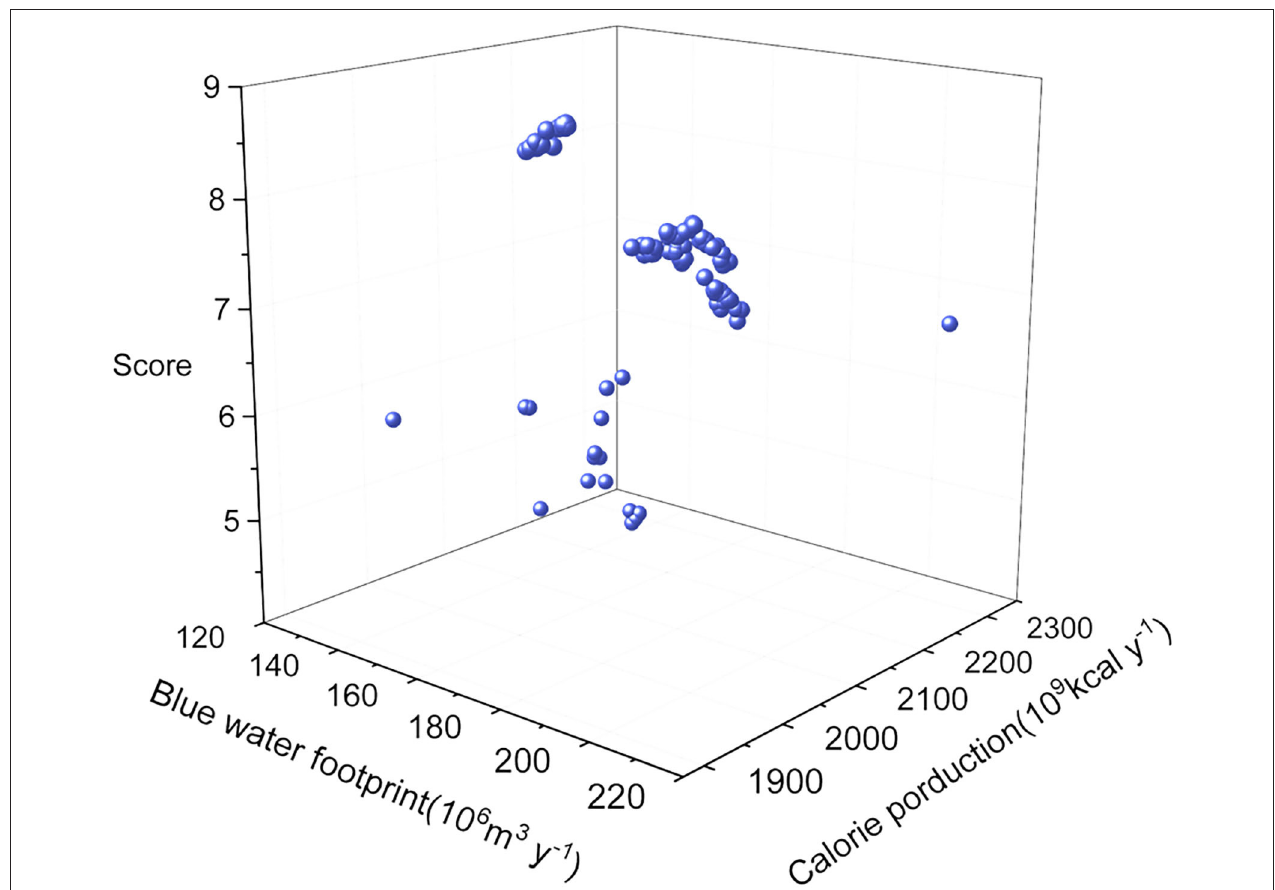
FIGURE 5 | Pareto solution set obtained by NSGA-II. Each point in the figure represents an optimization result.